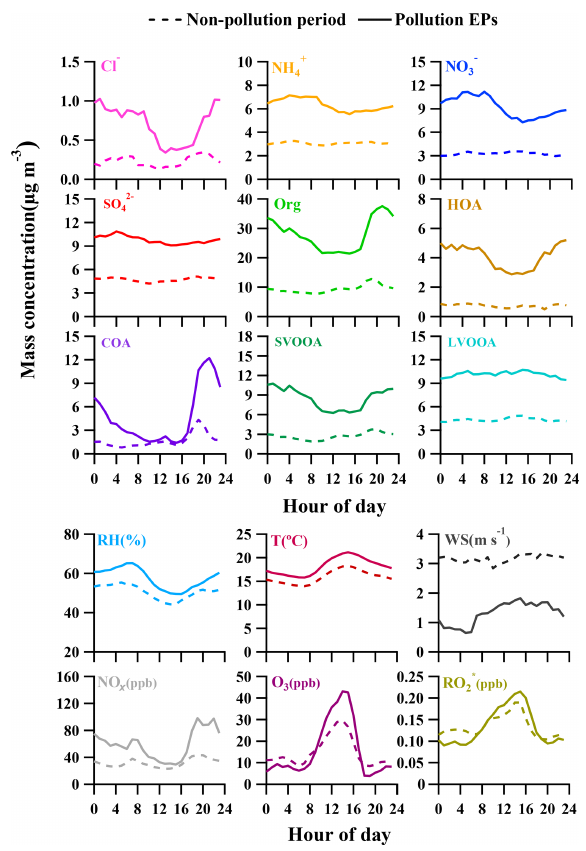
Figure 5. Diurnal profiles of NR-PM 1 species, trace gases, radicals, and meteorological conditions. Dashed lines and solid lines repre- sent the averaged values during non-pollution periods and pollution EPs.